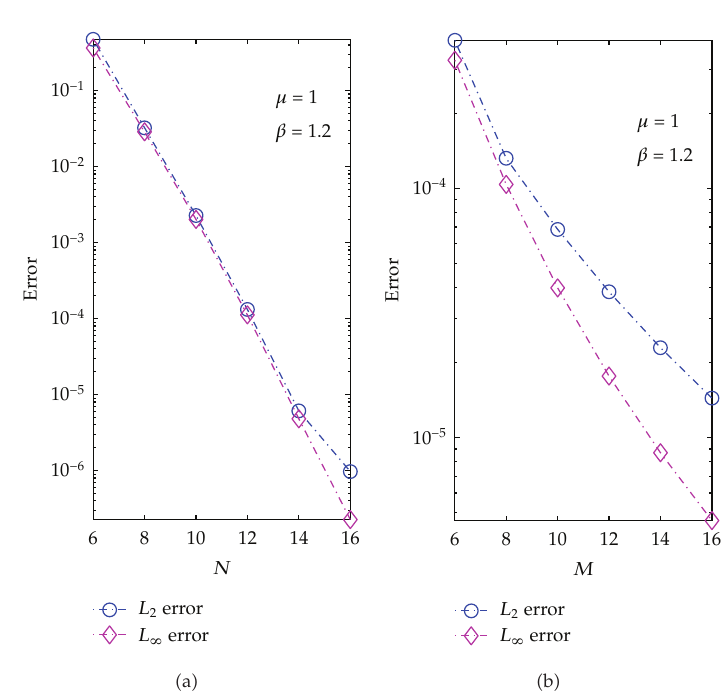
Figure 7: y -axis is log scale. (cid:4) a (cid:5) Errors versus N with M (cid:6) 16 ,μ (cid:6) 1. (cid:4) b (cid:5) Errors versus M with N (cid:6) 16 ,μ (cid:6) 1.